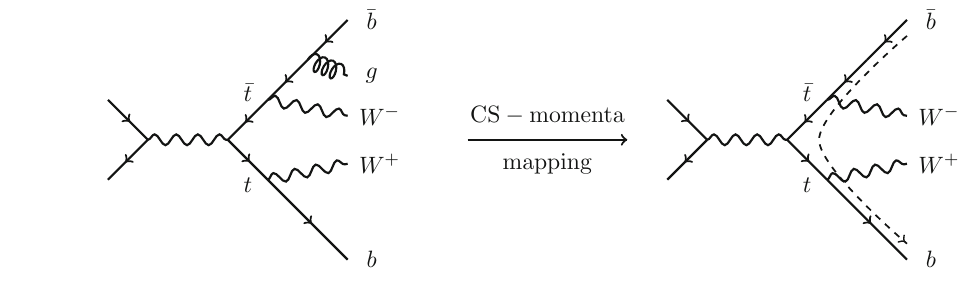
Fig. 2 Possible real correction configuration for W + W − b ¯ b production and Born configuration of associated standard CS-dipole. The curved arrow on the right indicates the flow of the recoil